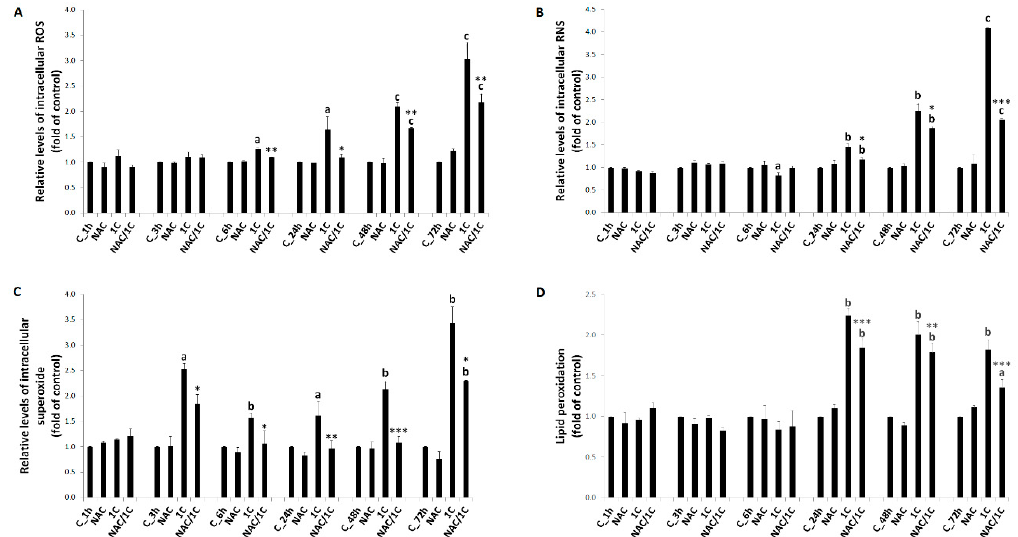
Figure 2. The influence of 1C and NAC/1C on free radical production in HCT116 cells. ( A ) Measurement of reactive oxygen species (ROS) levels after 6, 24, 48, and 72 h incubation ( B ) Relative levels of reactive nitrogen species (RNS) after 6, 24, 48, and 72 h incubation ( C ) Relative levels of superoxide after 3, 6, 24, 48, and 72 h incubation ( D ) Analysis of lipoperoxide production after 6, 24, 48, and 72 h incubation. Data were obtained from three independent measurements. Significantly different a p < 0.05, b p < 0.01, c p < 0.001 vs. untreated cells (control); * p < 0.05, ** p < 0.01, *** p < 0.001 vs. 1C. 8-Oxo-7,8-dihydroguanine (8-oxoG) is the main product of oxidative DNA damage. Because of